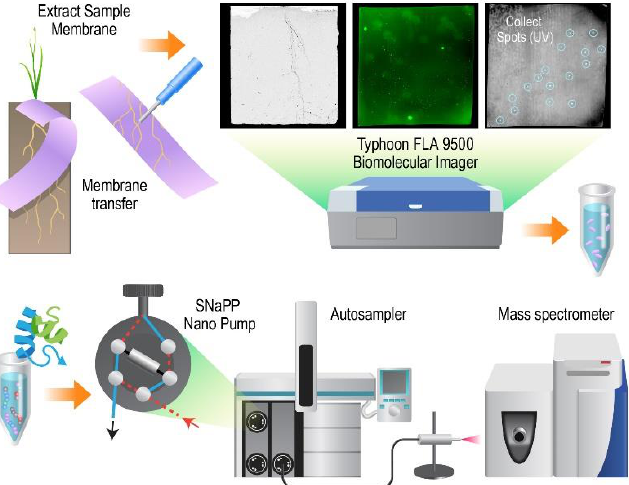
Figure 1. Setup of Rhizobox, sampling, and measurements. A pre-wetted nitrocellulose membrane is placed on an exposed soil surface on the side of a rhizobox and used to non-destructively remove mobile proteins from the sample while preserving their two-dimensional location on the membrane. Spatial distributions of collected proteins were determined using a general protein stain which helps guide excision of small (1 mm diameter) membrane sections used for proteomic analysis. Products of on-membrane trypsin digests were purified and separated using the SNaPP method [16] to minimize loses to increase overall proteomic yields from analysis by mass spectrometry.